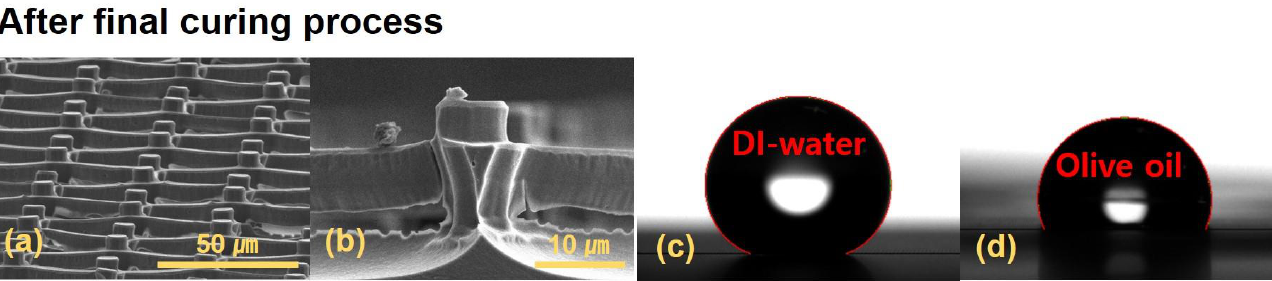
Figure 6. Micro-pattern deformation and improvement of omni-phobicity after final curing pro-cess; contact angle: ( a ) 50 µ m, ( b ) 10 µ m, ( c ) 160.3 ◦ ± 9.56 ◦ , ( d ) 105.9 ◦ ± 7.92 ◦